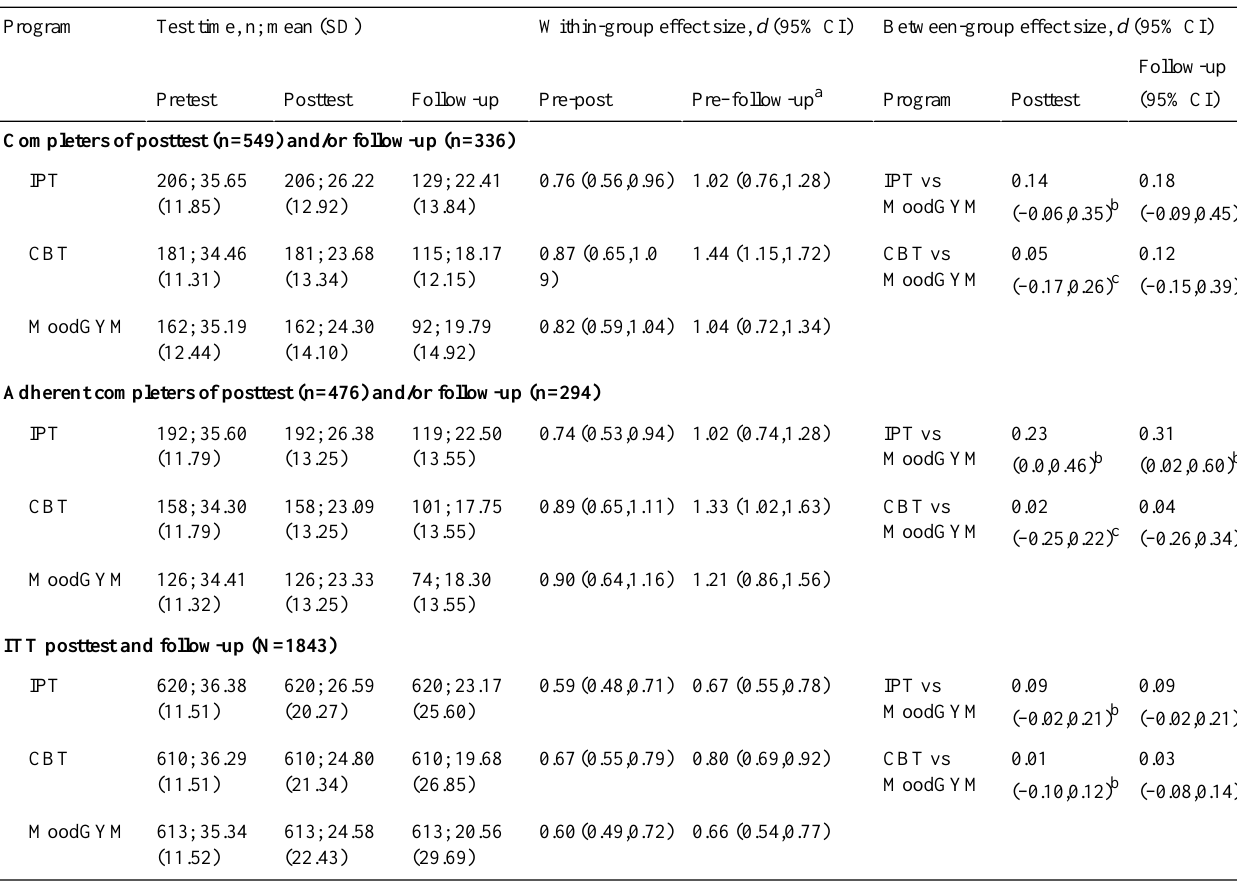
Table 2. Results and effect sizes (Cohen’s d ) for the Center for Epidemiological Studies Depression scale (CES-D) for completers and adherent completers, and for intention-to-treat (ITT) analyses.